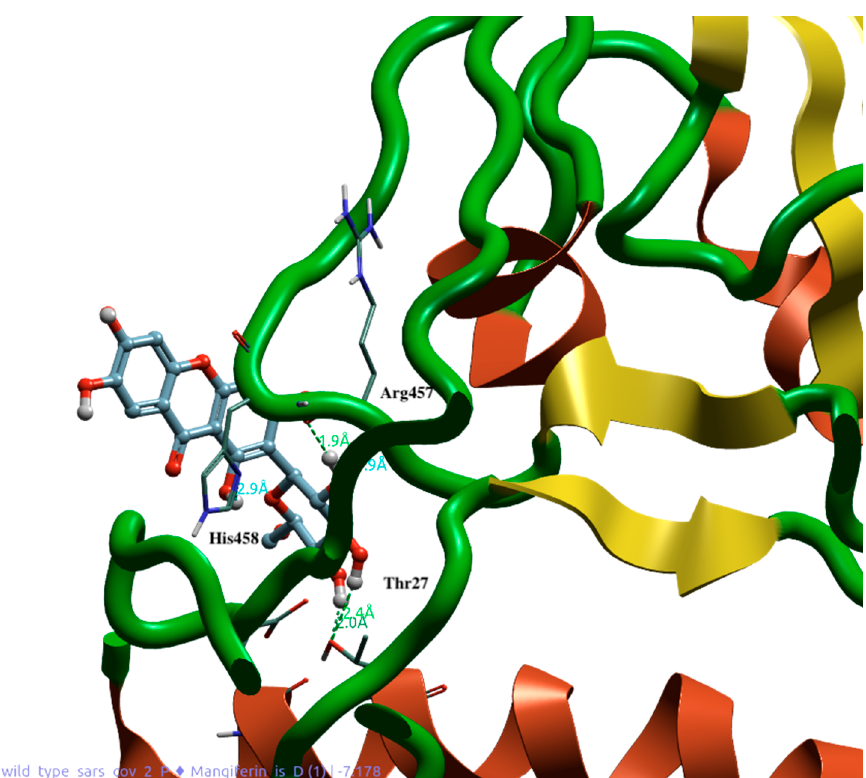
Figure 8. Docking position of MGF (1) in the binding interface between spike 1 (green and yellow) and ACE2 (red). Interaction with His34, Arg457, and His458. Water and accessory parts of spike and ACE2 were omitted for clarity.